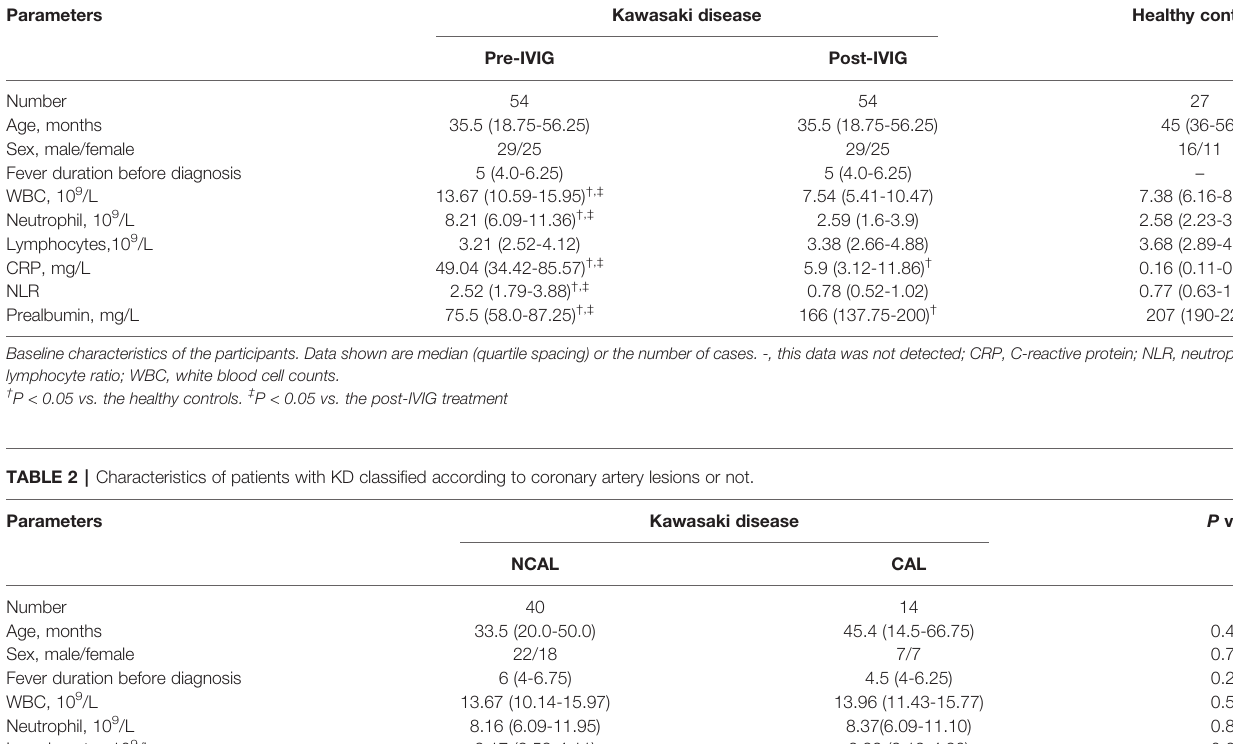
Baseline characteristics of the participants. Data shown are median (quartile spacing) or the number of cases. CAL, coronary artery lesion; CRP, C-reactive protein; NCAL, without coronary artery lesion; NLR, neutrophil to lymphocyte ratio; WBC, white blood cell counts.